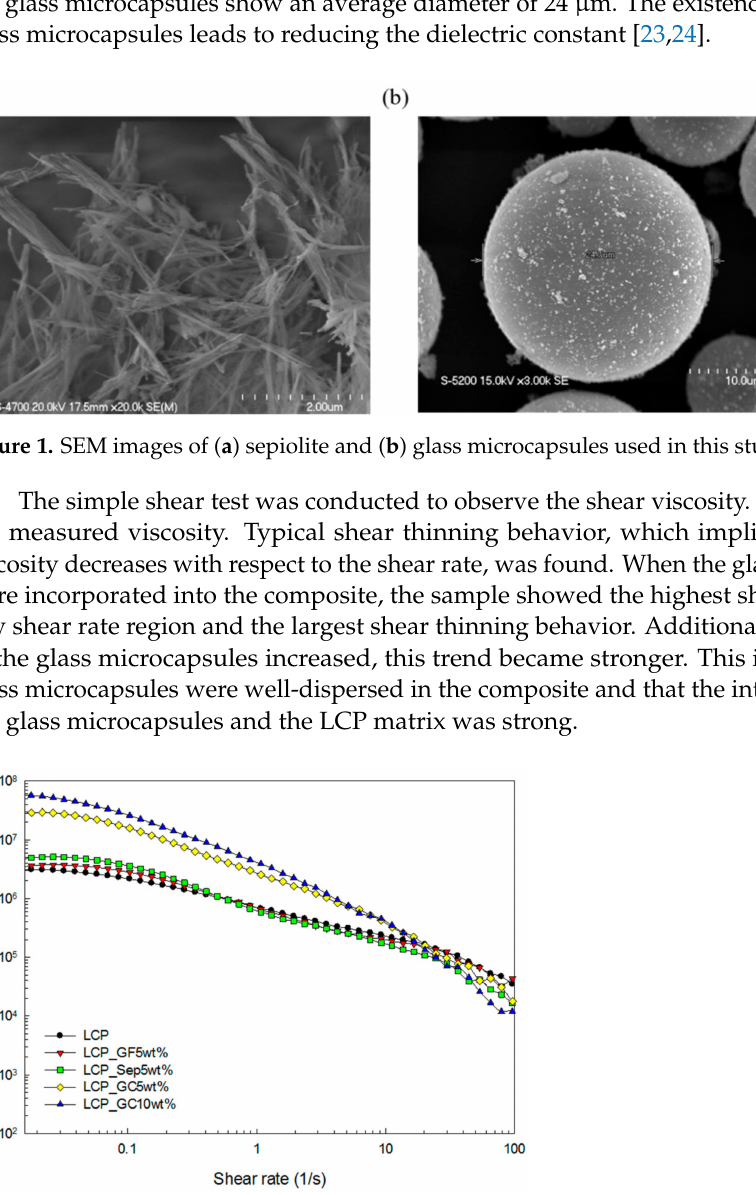
Figure 2. Shear viscosity of the composites as a function of the shear